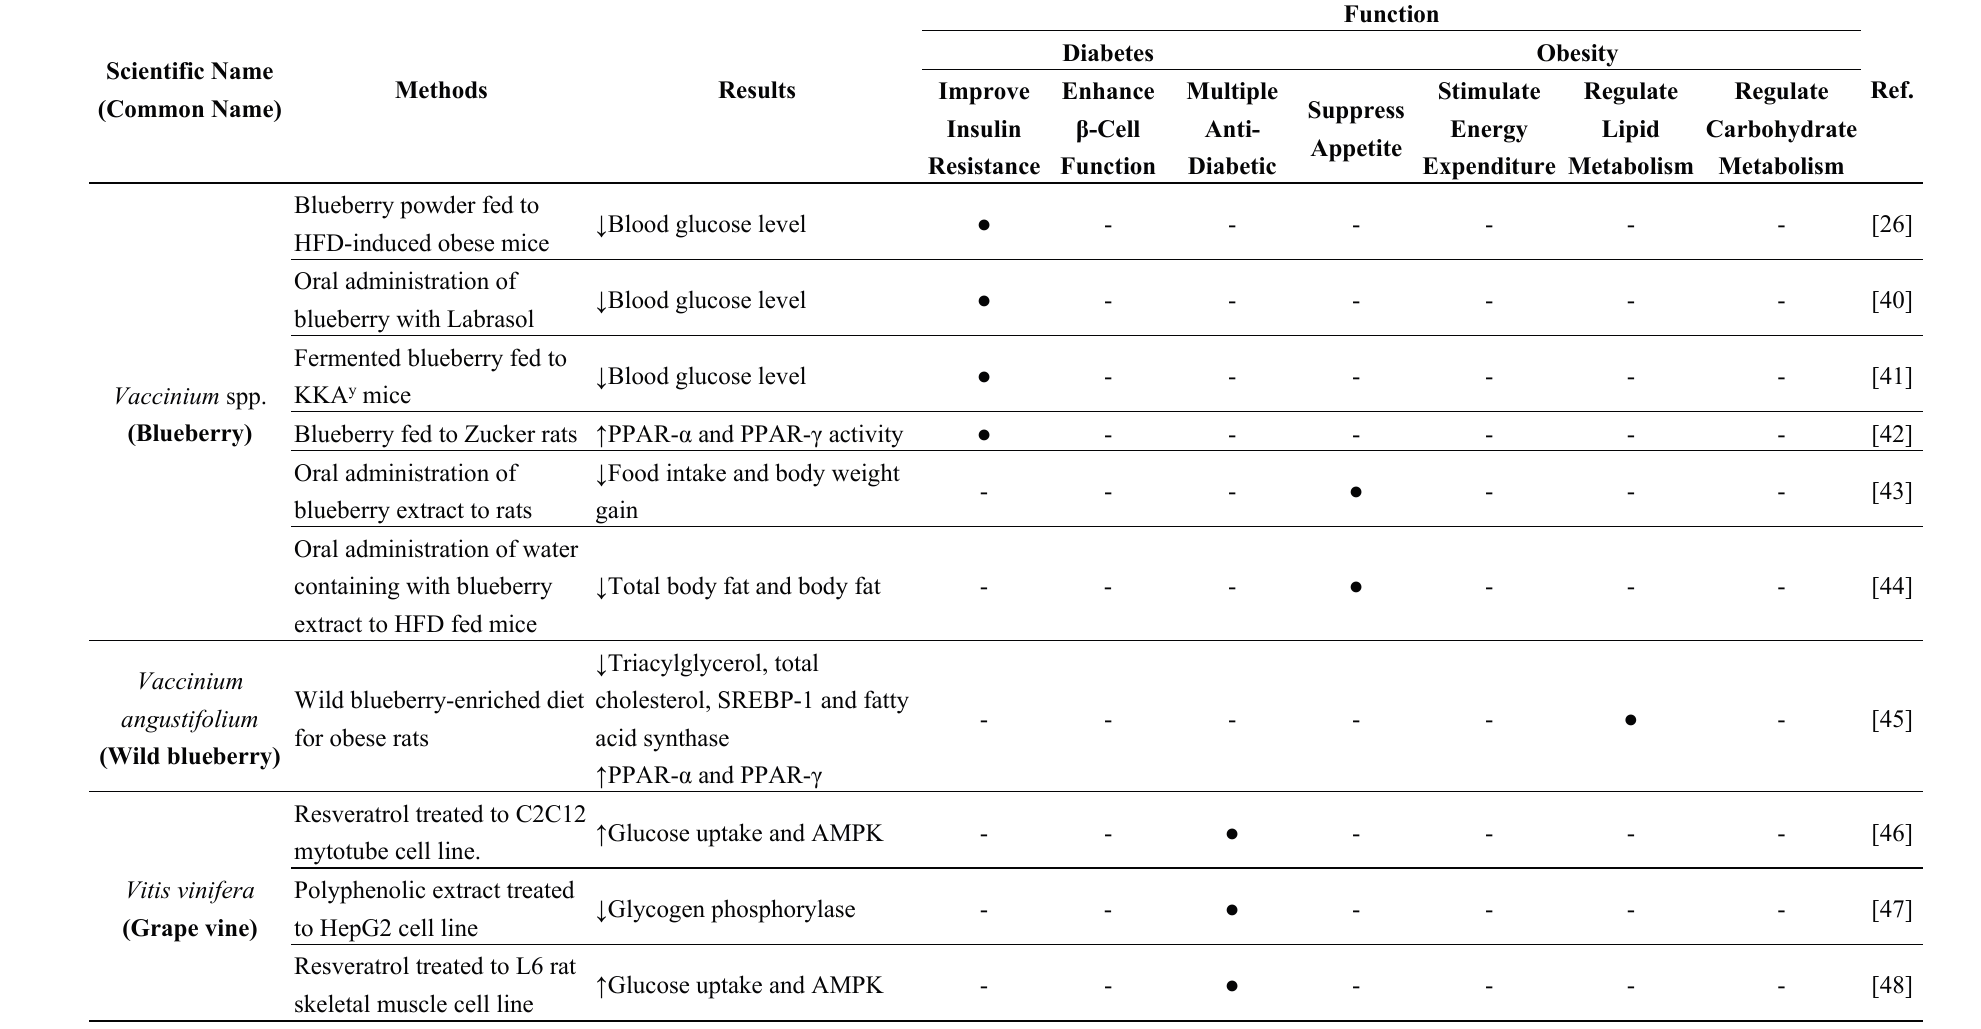
Table 1. Phytogenic compounds with potential for the development of treatments for obesity and